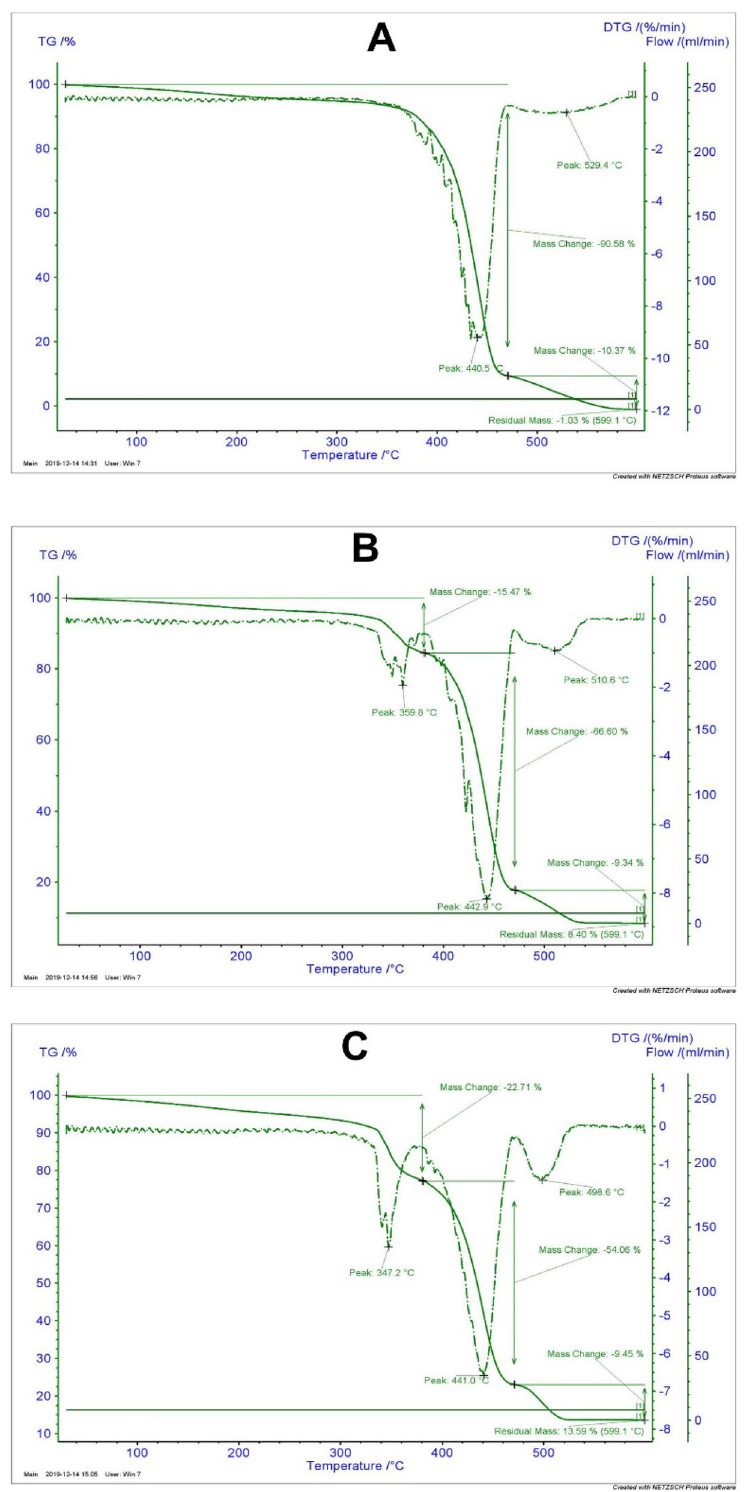
Figure 6. Analytical TGA and DTG graphs for ( A ) crude PA6, ( B ) PA6/PbO-10%, and ( C )